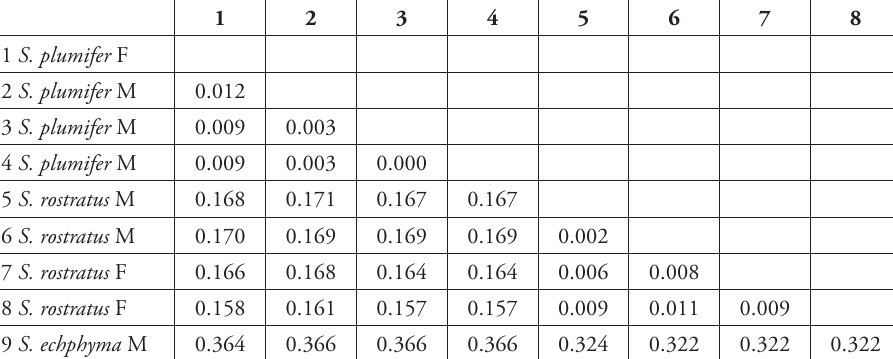
Table 2. Genetic distances (K2P) for barcode region of CO I among the Sperchon species analysed in this study. (‘F’ indicates female and ‘M’ indicates